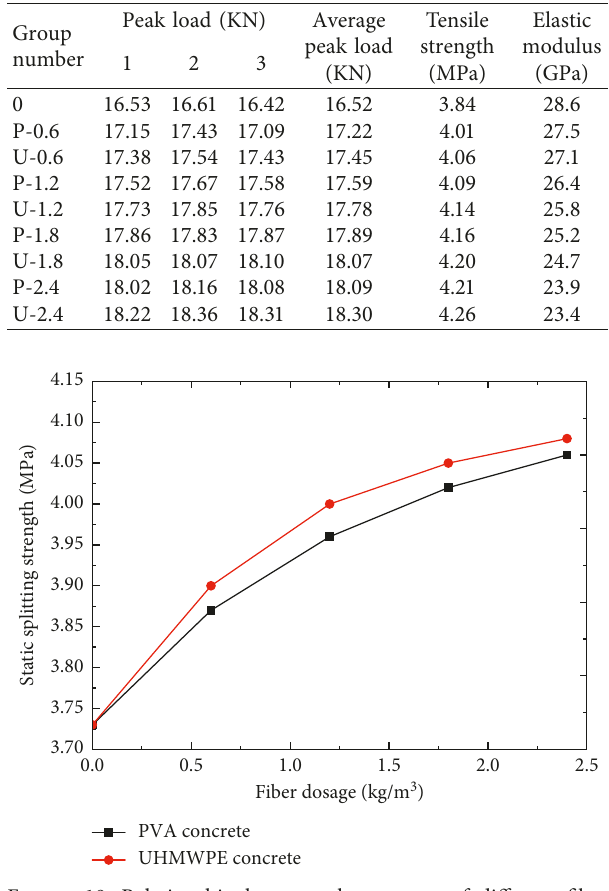
Table 6: Static tensile properties of fiber concrete of each group.